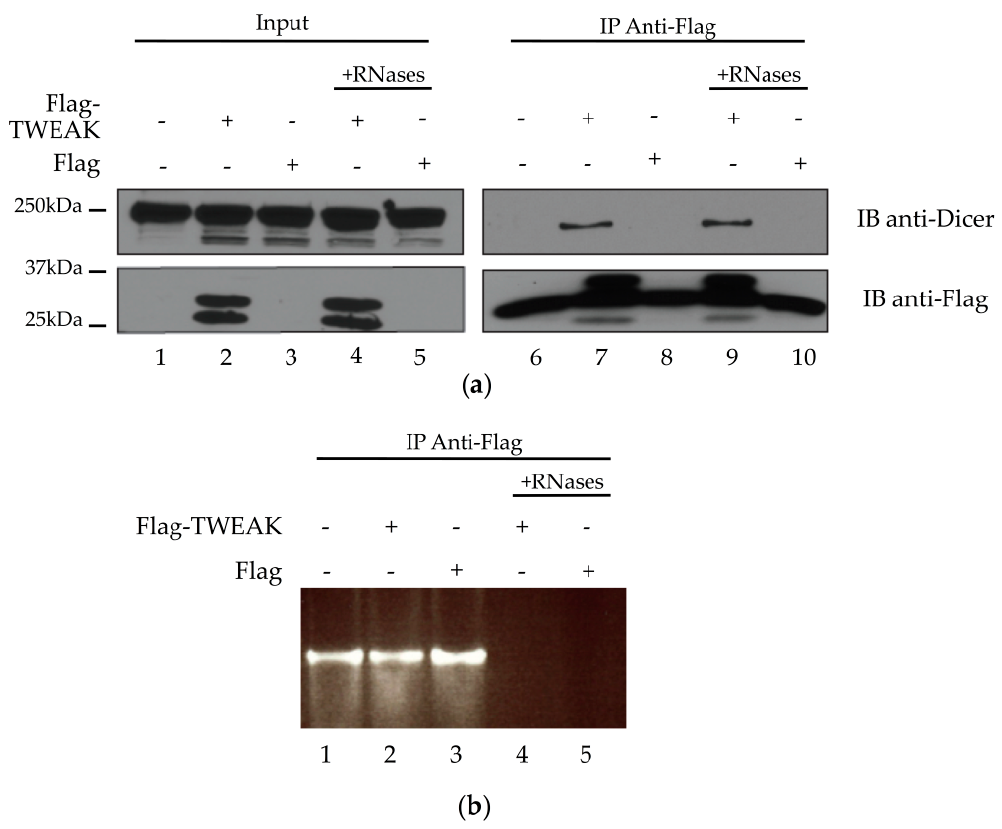
Figure 3. Dicer and TWEAK proteins form a complex likely independent of RNA in HEK 293 cells. HEK 293 cells were transiently transfected with pcDNA3.1-Flag-TWEAK vector, or an empty pcDNA3.1-Flag vector (Flag), prior to Flag-TWEAK protein immunoprecipitation (IP) from untreated lysate (lanes 1–3 and 6–8) or lysate treated with RNases A/T1/V1 (+RNases; lanes 4–5 and 9–10). ( a ) The presence of Flag-TWEAK and Dicer proteins in the lysates (Input) and the IPs was verified by immunoblot (IB) analysis using anti-Flag and anti-Dicer antibodies. The two bands immunoreactive to the anti-Flag antibody likely correspond to different posttranslational forms of the Flag-tagged TWEAK protein. The band across lanes 6 to 10 of the IB anti-Flag panel likely corresponds to the light chain of mouse IgGs; ( b ) RNA degradation upon treatment with RNases A/T1/V1 was confirmed by agarose gel electrophoresis and ethidium bromide staining.